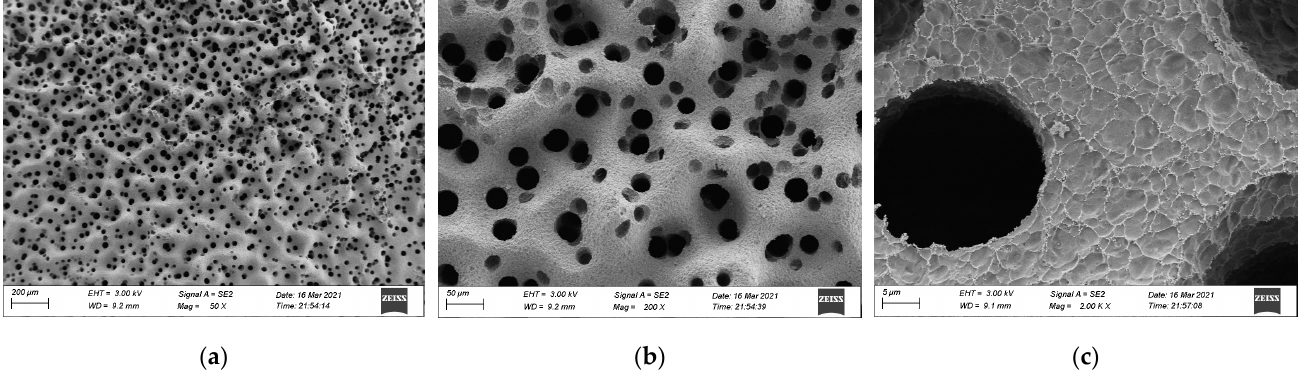
Figure 13. Morphology of residual carbon after the cone calorimeter test of base asphalt: ( a ) 50×, ( b ) 200×, and ( c ) 2000× magnification.